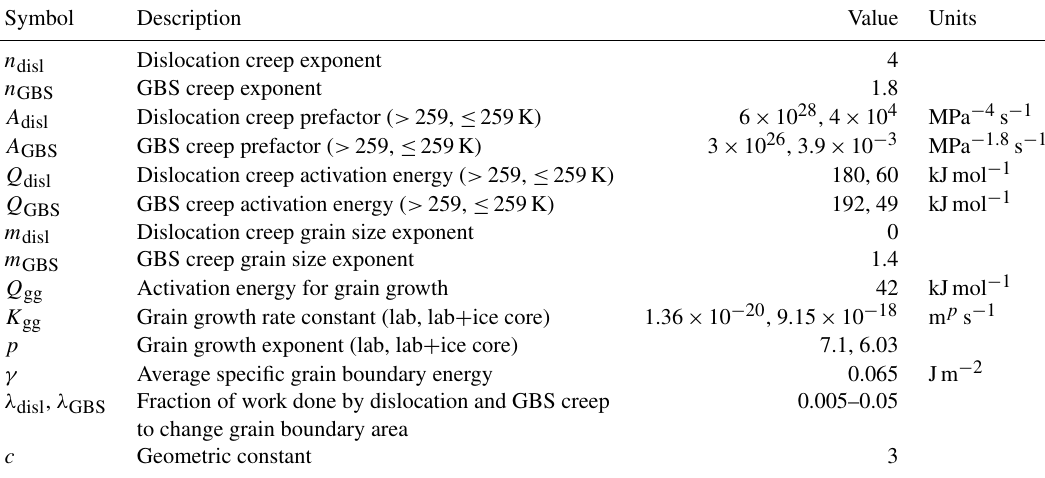
Table 1. Flow law and model parameters.